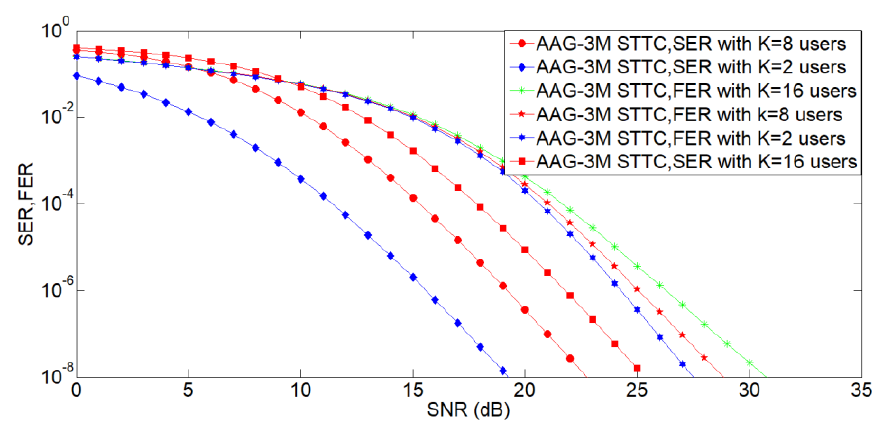
Figure 6. Comparison of AAG for urban Scenario with and without Massive MIMO in terms of SER and FER.